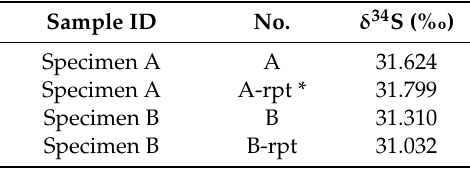
Table 3. Sulfur isotope data for the pyrites in this study.